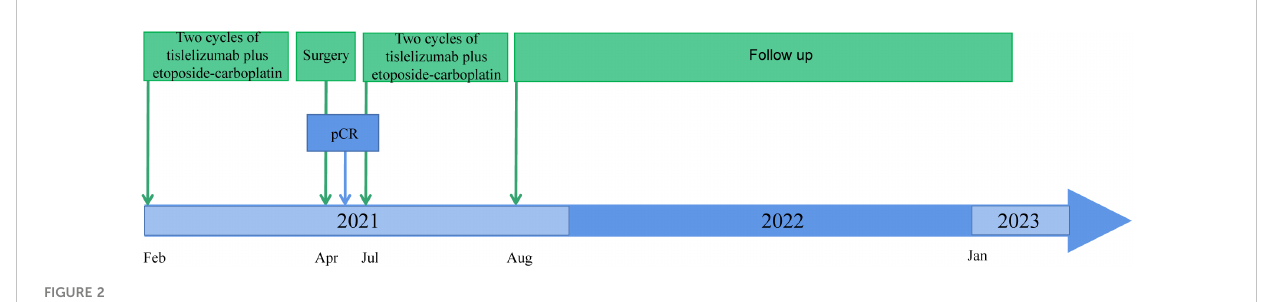
FIGURE 2 Timeline from January 2021 to January